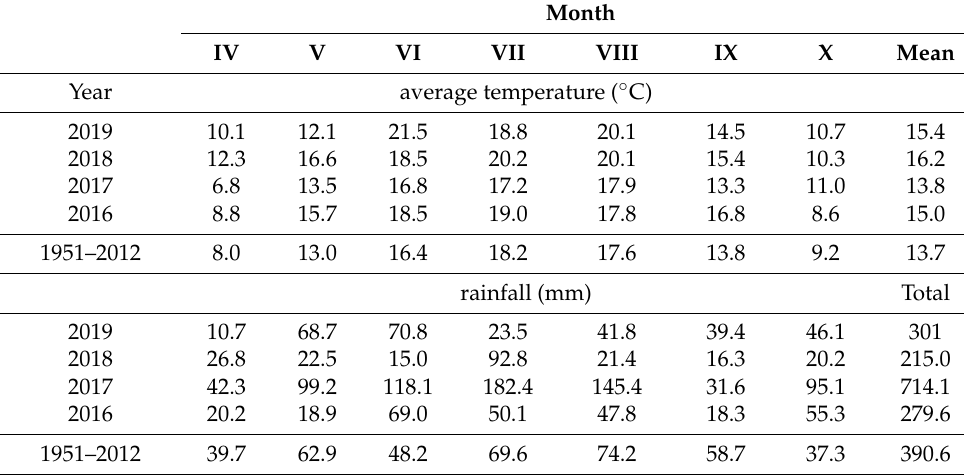
Table 1. Temperature and rainfall in the period from April to October (vegetation season) in 2016–2019 compared to the multiannual period (1951–2012) in